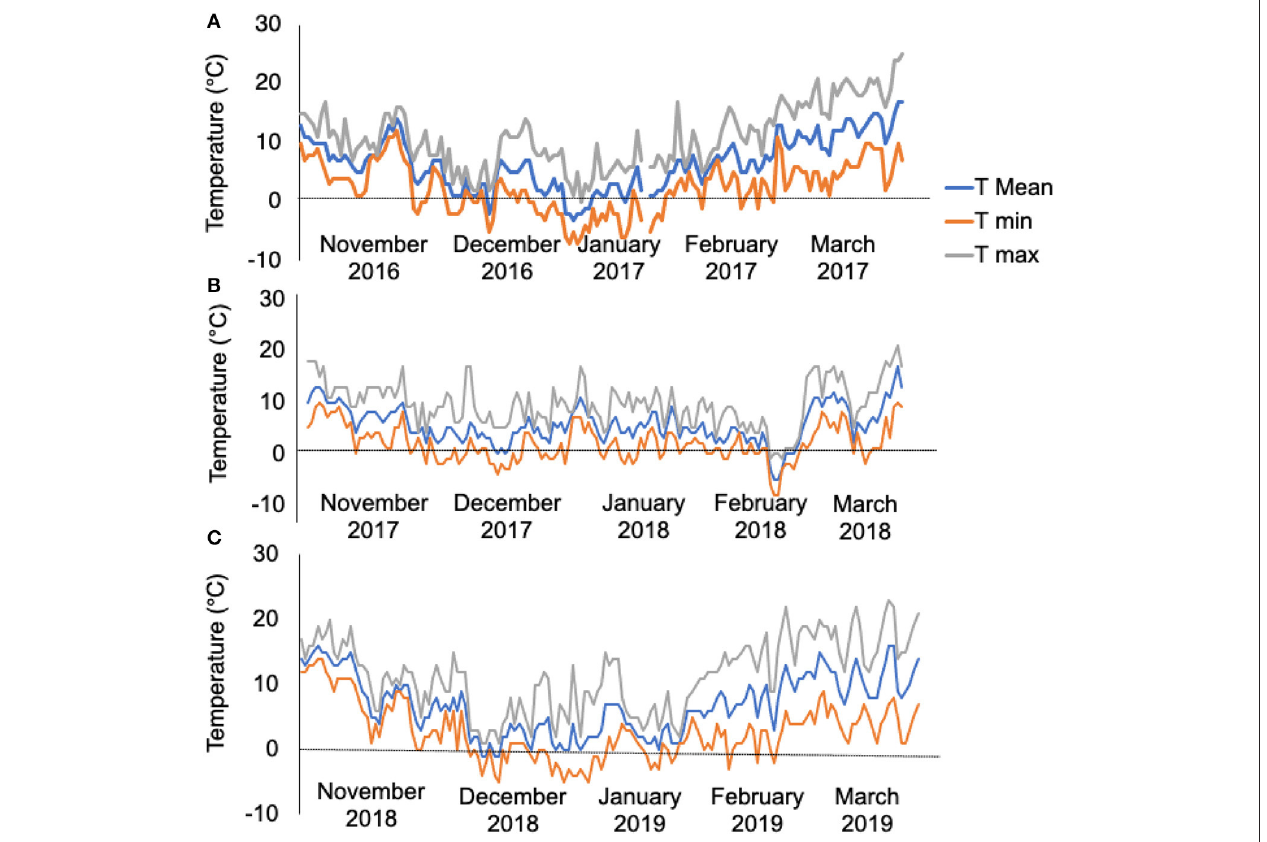
FIGURE 1 | (A) Temperature profiles as recorded from the field during 2016–2017, 50 days of temperatures < 0 ◦ C. (B) Temperature profiles as recorded from the field during 2017–2018, 35 days of temperatures < 0 ◦ C. (C) Temperature profiles as recorded from the field during 2018–2019, 33 days of temperature < 0 ◦ C. The trend line in gray, orange, and blue represents maximum temperature (T max), minimum temperature (T min), and mean temperature (T mean) per day of the month,